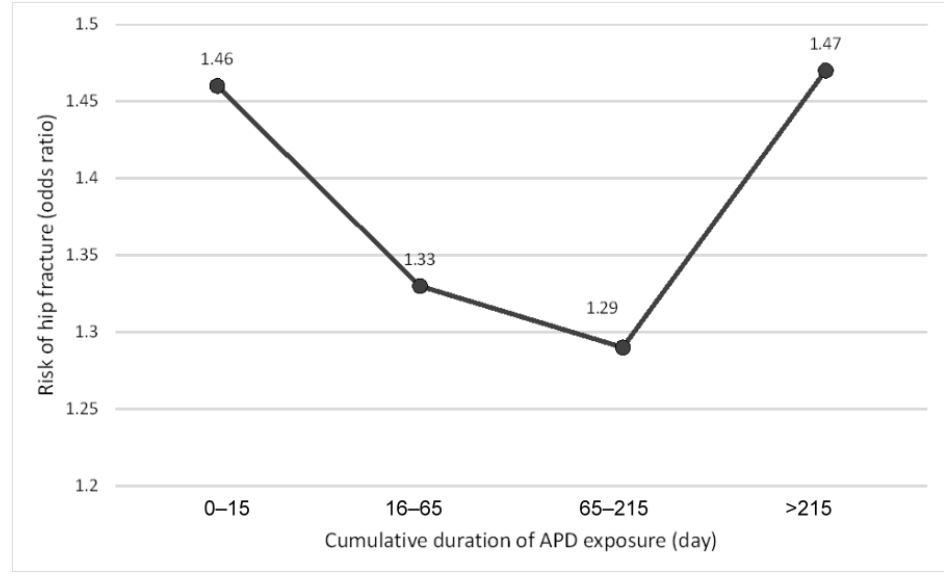
Figure 2. The risk of hip fracture in groups with different cumulative duration of antipsychotic drug (APD) exposure compared to APD nonusers.